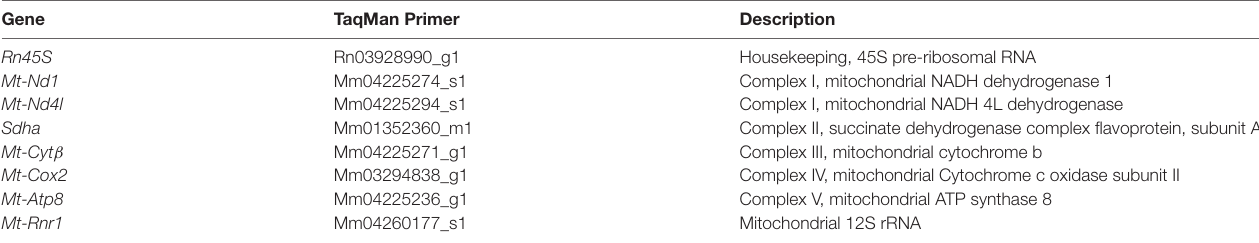
TABLE 1 | List of TaqMan primers for RT-qPCR analysis. Gene TaqMan Primer